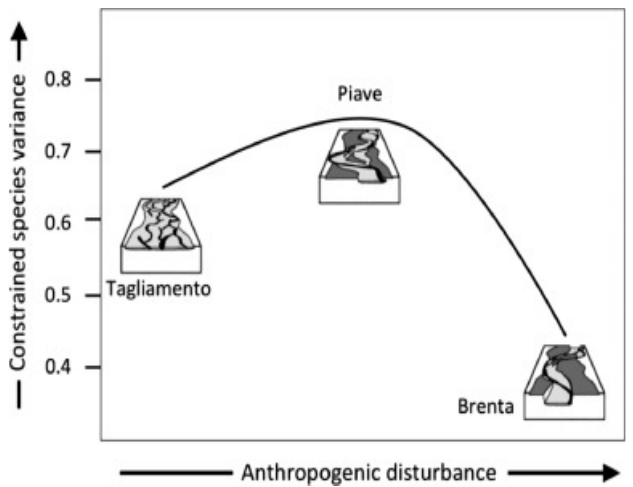
Figure 10. Schematic diagram showing how the variance of woody species explained by